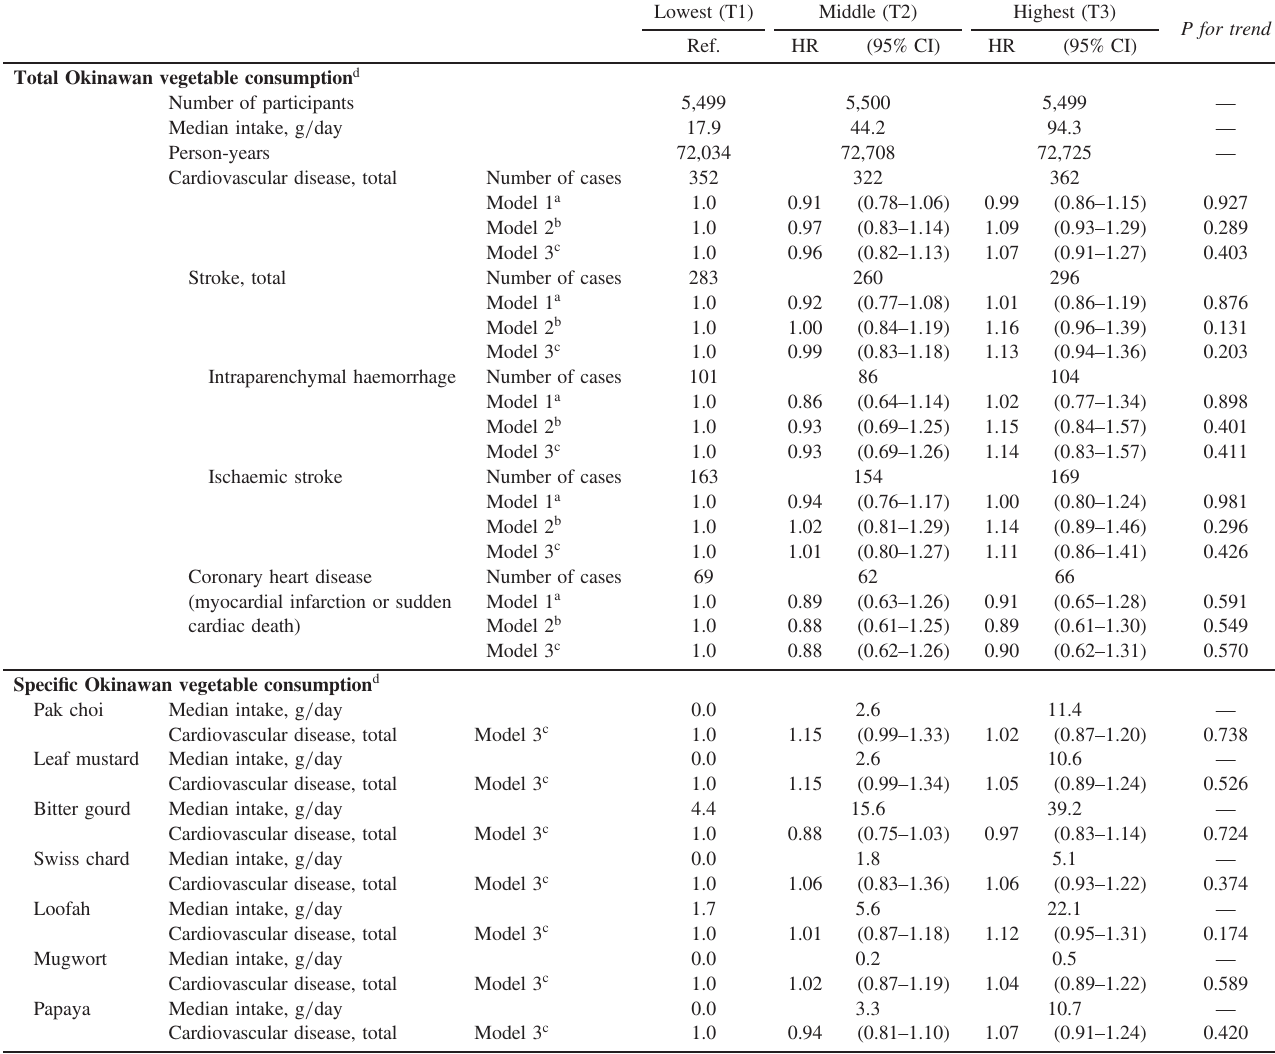
Table 3. Age-, sex-, and study area-adjusted and multivariate-adjusted hazard ratios and 95% con fi dence intervals of incident cardiovascular outcomes according to tertiles of total and speci fi c Okinawan vegetable consumption